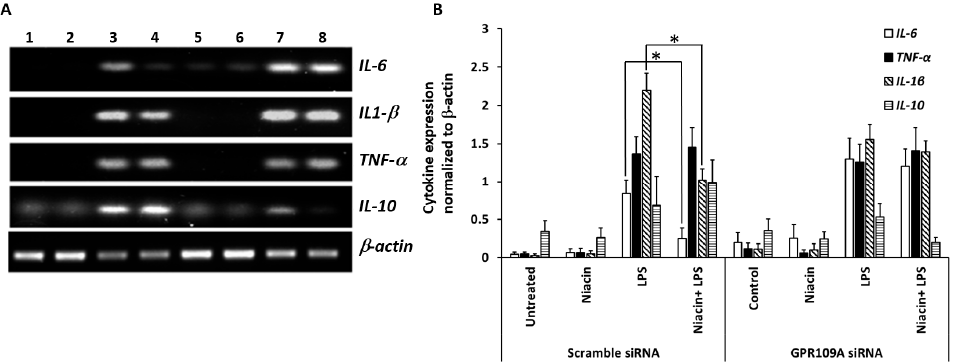
Figure 6. Expression of pro- and anti-inflammatory cytokine transcripts in RAW264.7 cells after GPR109A knockdown and LPS stimulation in the presence and absence of niacin. ( A ) Gene expression analysis of IL-1 β , IL-6, TNF- α , and IL-10 transcripts in RAW264.7 cells transfected with scrambled (lanes 1–4) or GPR109A siRNA (lanes 5–8). Treatments groups were untreated controls (lanes 1, 5), niacin only (lanes (2, 6), LPS only (lanes 3, 7) and LPS in the presence of niacin (lanes 4, 8). ( B ) Densitometric analysis of changes in the expression levels of cytokine genes relative to β -actin. Data presented as Mean ± SD of 3 replicates. * p < 0.05.